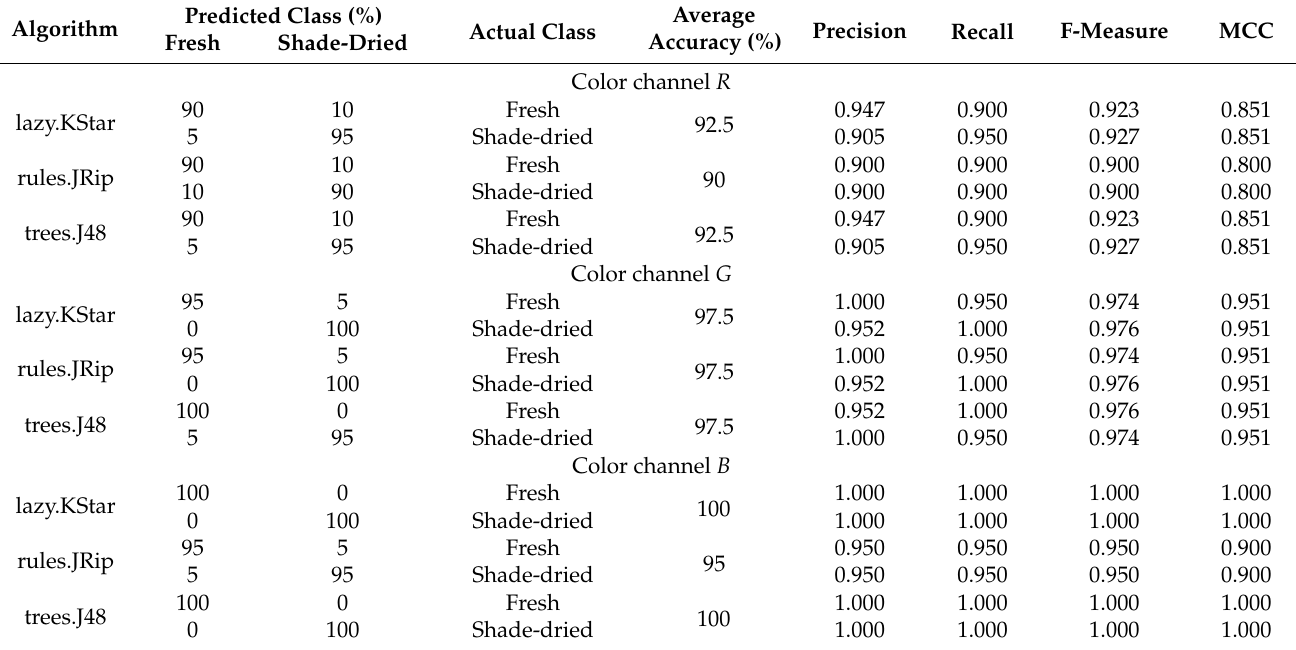
Table 1. The classification of images of the ventral side of fresh and shade-dried mint leaves based on selected textures from color channels R , G , and B belonging to color space RGB.